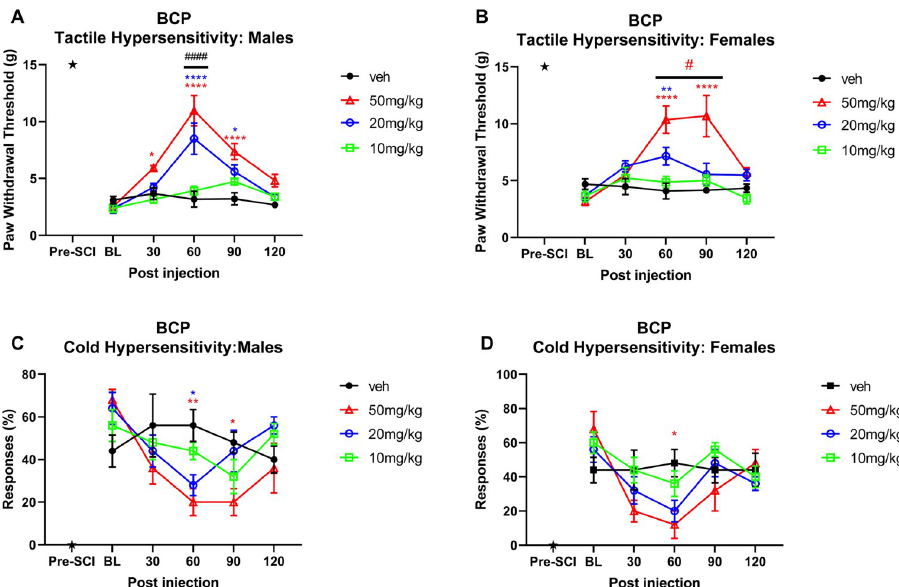
Fig 3. Time course of BCP antinociceptive in male and female rats. Time plots of the effect of BCP (10, 20, 50 mg/ kg) and matched vehicle on mechanical PWT in A) males and B) females and acetone responses in C) males and D) females (n = 5–6 per treatment group). Animals received a single oral administration at time 0h, 4 weeks post SCI surgery; pre-SCI data is also displayed (indicated by star). � , �� , ���� denote p < 0.05, 0.01, and 0.0001 compared to vehicle for each treatment group. A) ####p < 0.001 for 50mg/kg vs 10mg/kg and 20mg/kg vs 10mg/kg B) #p at least < 0.05 for 50mg/kg vs lower BCP